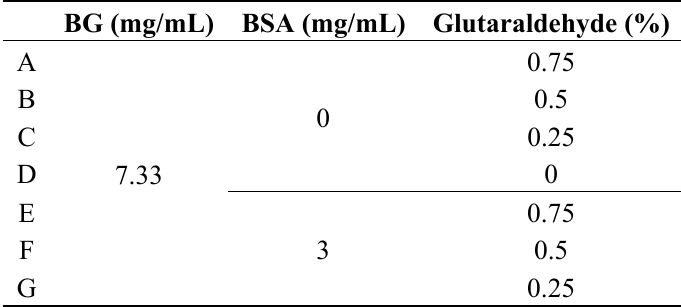
Table 1. Cross-linking conditions for β -glucosidase prior to enzyme immobilization in calcium alginate beads.